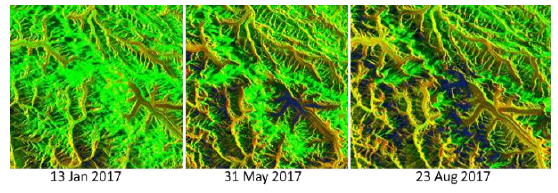
Figure: 15: Seasonal Sentiel-1 SAR data for Siachen glacier